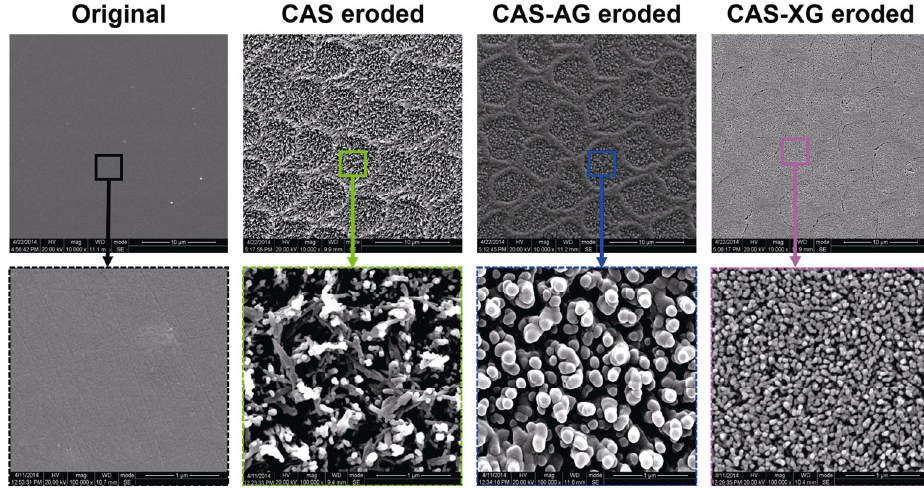
Fig. 2 SEM micrographs of the enamel surfaces subjected to different erosion